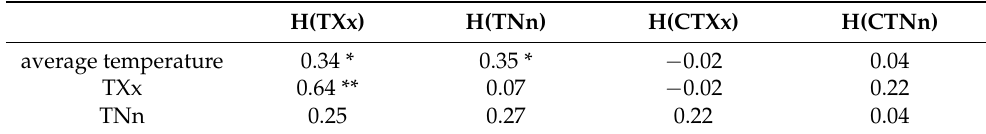
Table 2. Correlation matrix of annual average temperature and H values (extreme climate instability index).